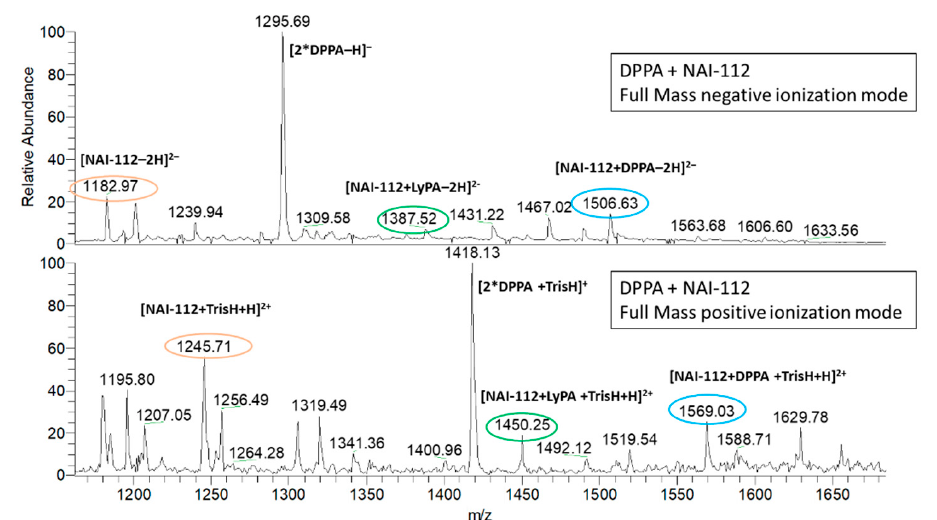
Figure 4. Mass spectra of the sample containing DPPA and NAI-112 in negative ionization mode ( upper spectrum) and in positive ionization mode ( lower spectrum). Addition of Tris to improve DPPA solubility led to the formation of Tris adducts, visible in positive ionization mode. The orange circle indicates the lanthipeptide alone, and green and blue circles show the lanthipeptides complexed with LPA and DPPA, respectively.